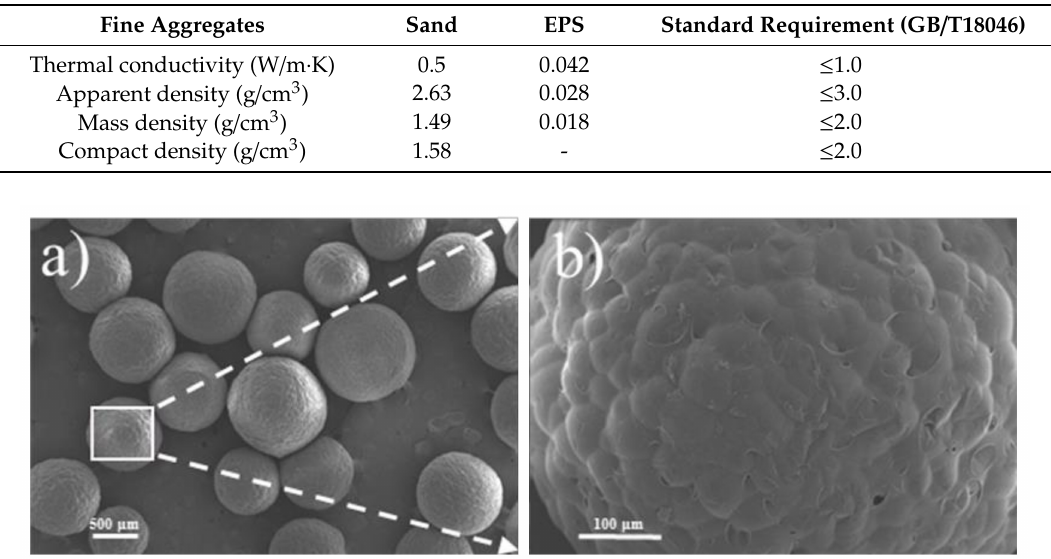
Figure 2. Particle size distributions of standard sand and waste EPS beads. Table 3. Physical characteristics of sand, waste EPS, and standard requirements.